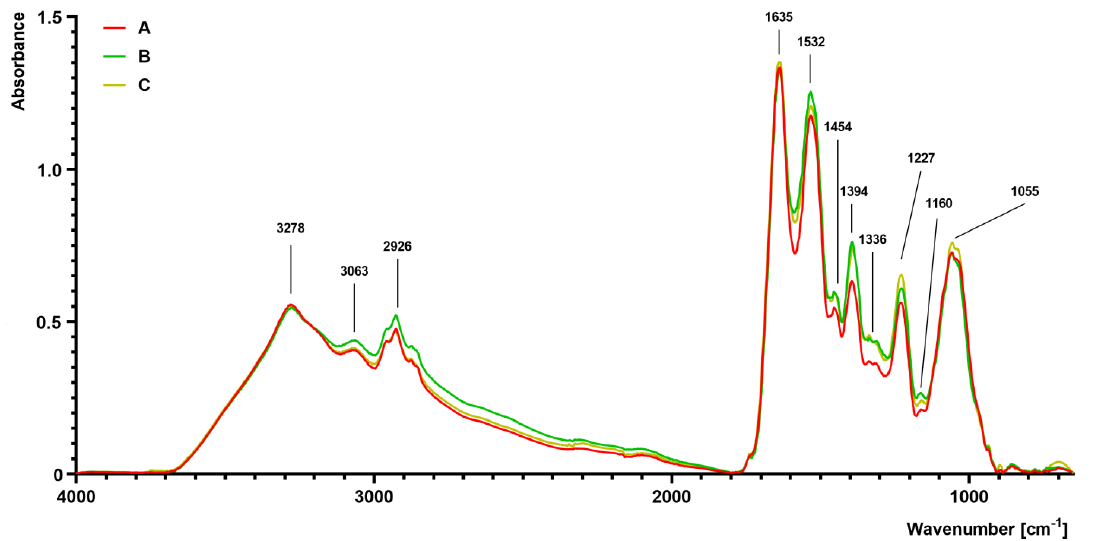
Figure 4. Fourier transform infrared (FTIR) spectroscopy analysis of S. aureus Newman strain isolated from different modifications of the Mueller-Hinton agar: non-supplemented (control medium A); supplemented with 1% ( v/v ) Tween 80 (medium B); supplemented with 1% ( v/v ) Tween 80 and trans -anethole at subinhibitory concentration — MIC 50 (medium C).